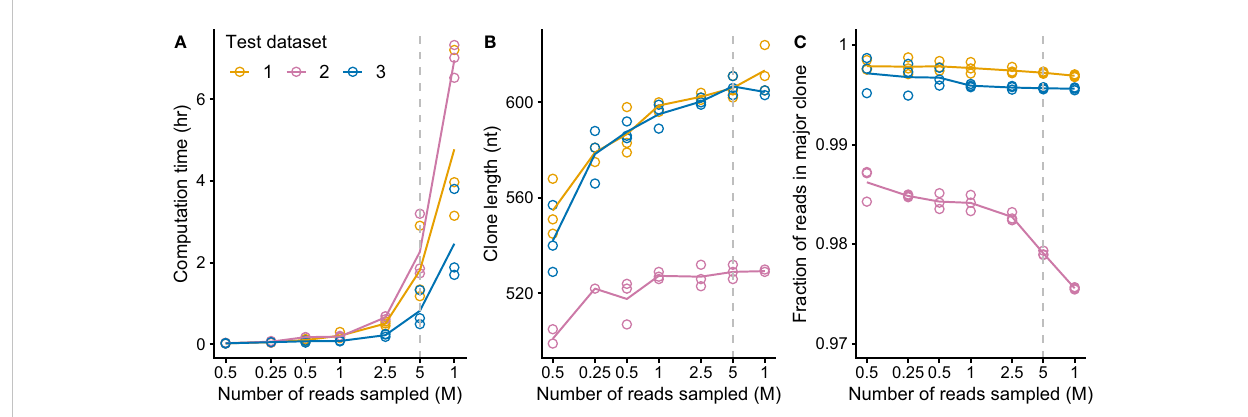
FIGURE 3 MiXCR identi fi es IGV L - IGJ L clones from an input of fi ve million randomly sampled reads. For each of three CoMMpass cases, random samples of reads (three replicates each of seven sample sizes) were used as the input to MiXCR and the resulting clonal sequences were analyzed. Dashed lines show the results using 5M reads, which was chosen as the target for down-sampling. (A) Computation time for varying amounts of input reads, using four cores on an Intel Xeon processor. (B) Length of output top IGV L -IGJ L clone for varying amount of input reads. (For comparison, a typical IGV L -IGJ L sequence is approximately 330 nt.) For cases where the output from MiXCR comprised multiple non-contiguous segments for a single clone, only the longest segment was considered. (C) Fraction of counts assigned by MiXCR to the major IGV L -IGJ L